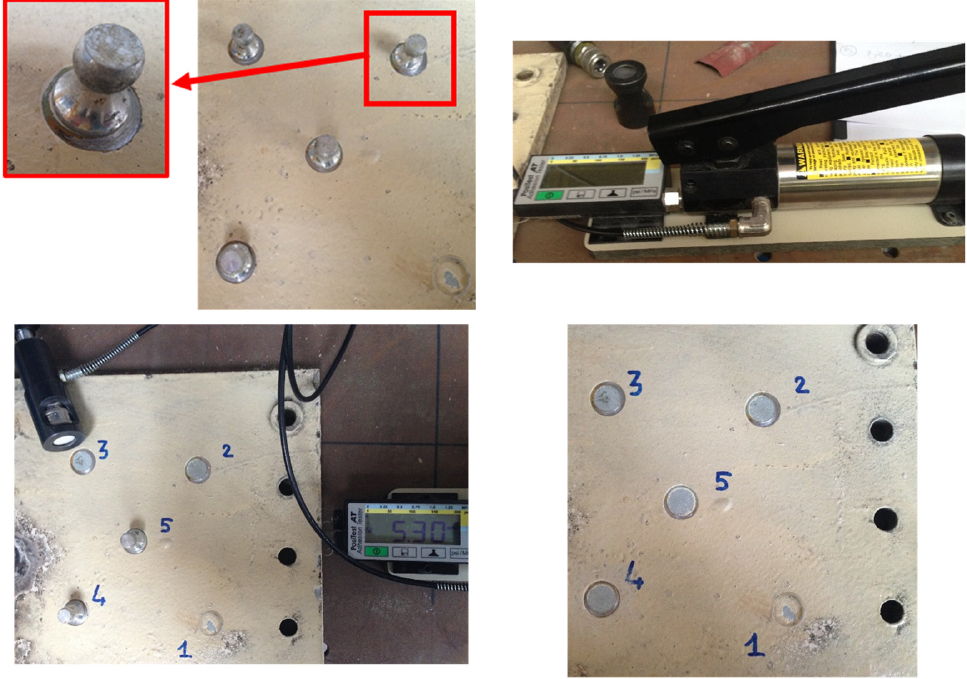
Figure 14. Example of DFT measurement gauges.